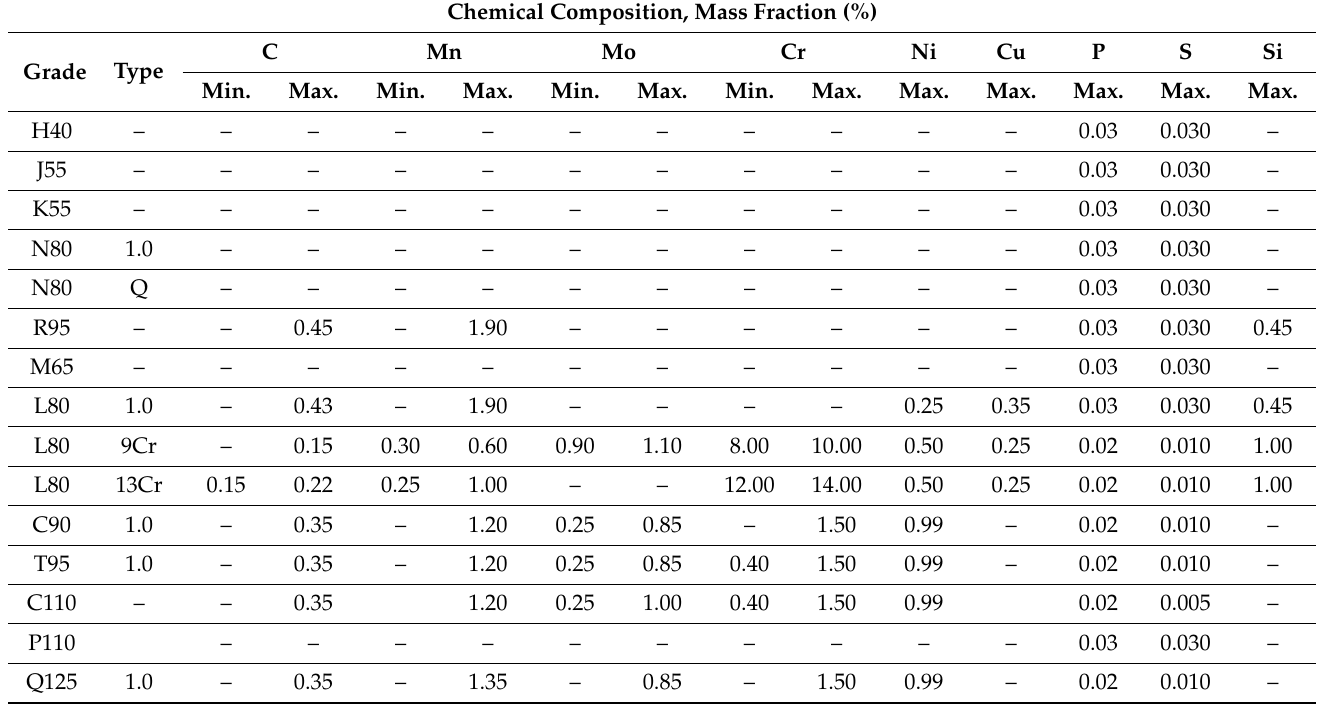
Table 3. Composition of corrosion resistant steels and alloys for downhole tubing and casing [10]. Chemical Composition, Mass Fraction